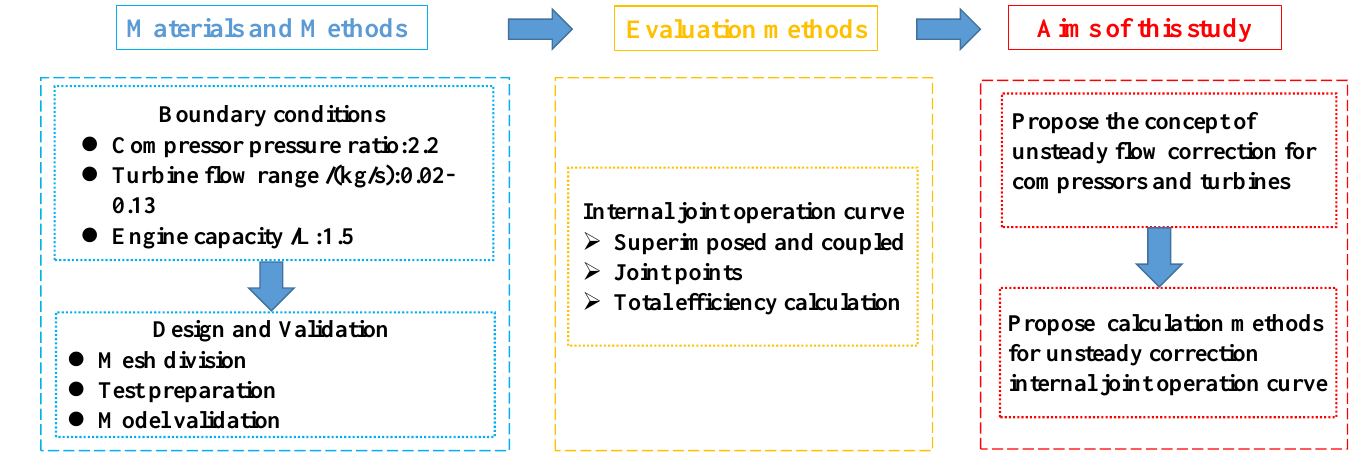
Figure 1. Flow chart of study framework.